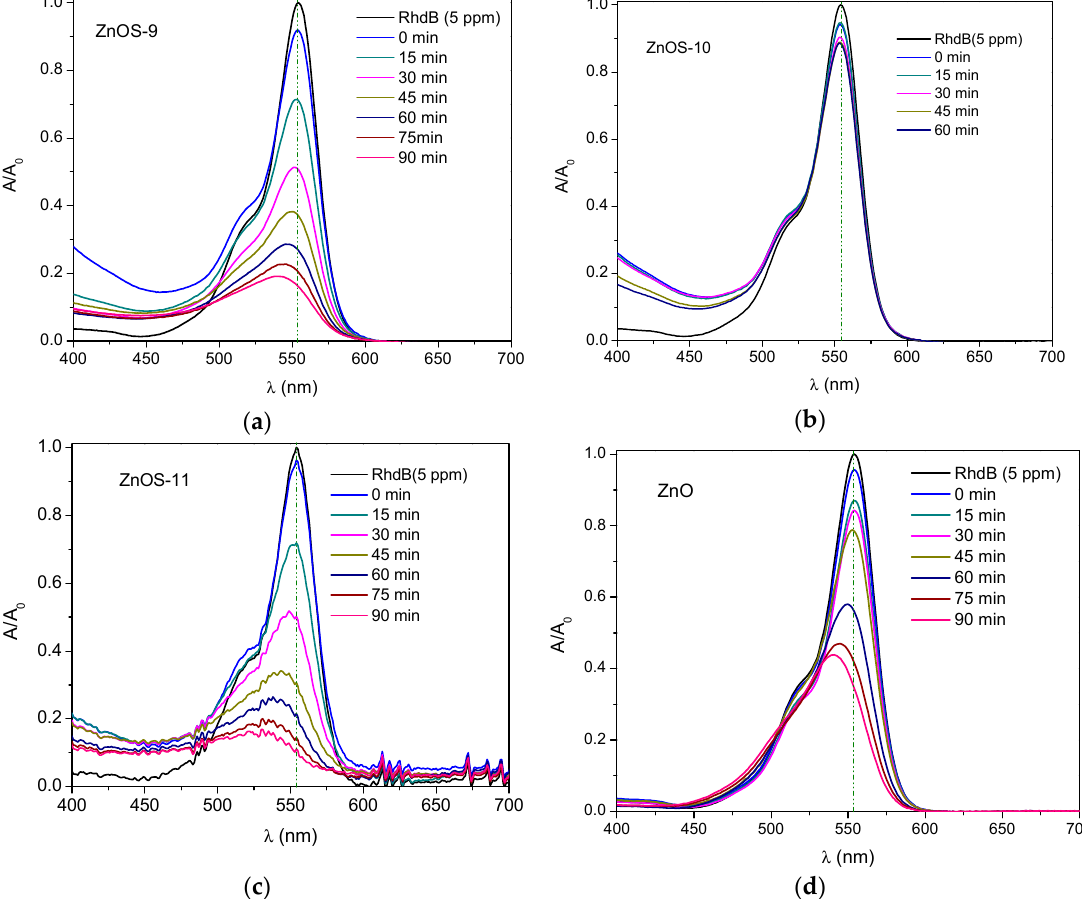
Figure 5. Normalized UV-vis spectra during the degradation of Rhodamine B for the as-synthesized ZnOS heterostructures, ( a ) ZnOS-9, ( b ) ZnOS-10, ( c ) ZnOS-11, and ( d ) ZnO.